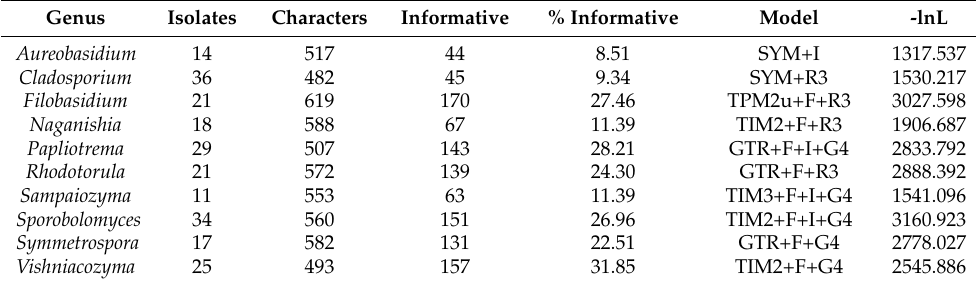
Table 1. Features of sequence datasets and results of maximum likelihood (ML) inference by genus. Presented are the number of included isolates, number of total characters, number and percentage of parsimony-informative characters, the model of nucleotide substitution according to the corrected Akaike Information Criterion and the -lnL score of the best ML